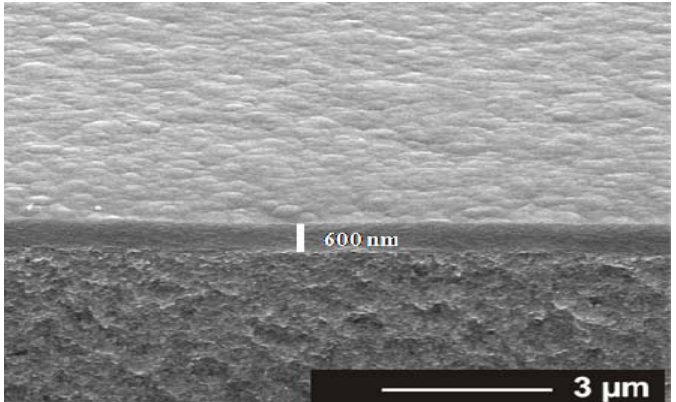
Figure 2. Cross-sectional SEM pictures of a representative plasma deposited TAA polymer thin film on ADP-Morgane ® membrane, performed in the following conditions: = 40 W, DC = 10% and τ = 60 P w